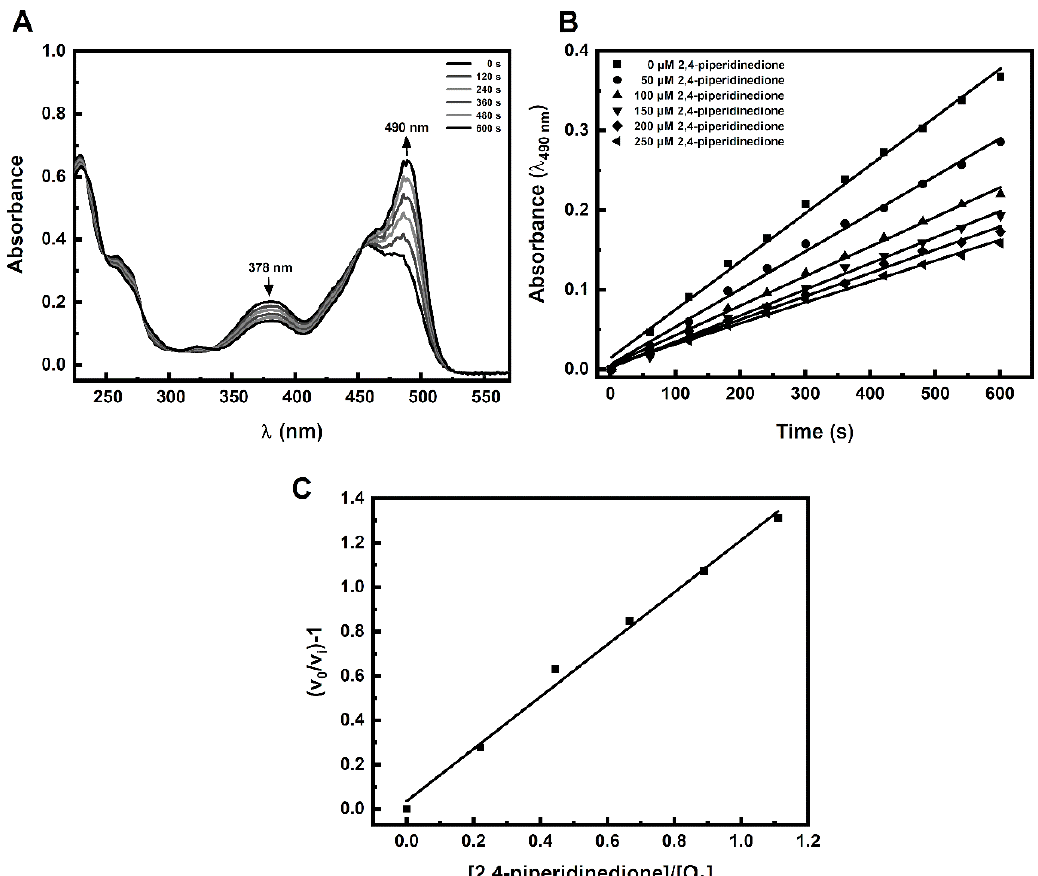
Figure 1. ( A ) Changes in the absorption spectrum due to oxidation of a boronate probe (FlBA) in an aerated aqueous solution of Angeli’s salt in the absence of HNO scavengers. ( B ) An example of the effect of an HNO scavenger 2,4-piperidinedione on the initial rate of fluorescein formation from the FlBA boronate probe. ( C ) Example plot of ( v 0 / v i ) − 1 versus the [S]/[O 2 ] ratio. The reaction mixture contained: 25 µ M FlBA, 20 µ M Angeli’s salt, 2,4-piperidinedione (0–250 µ M), phosphate buffer (pH 7.4, 50 mM), dtpa (100 µ M). Each solution contained 5% (vol.) CH 3 CN. The concentration of molecular oxygen was assumed to be 225 µ M. Measurements were carried out at 25 °C.